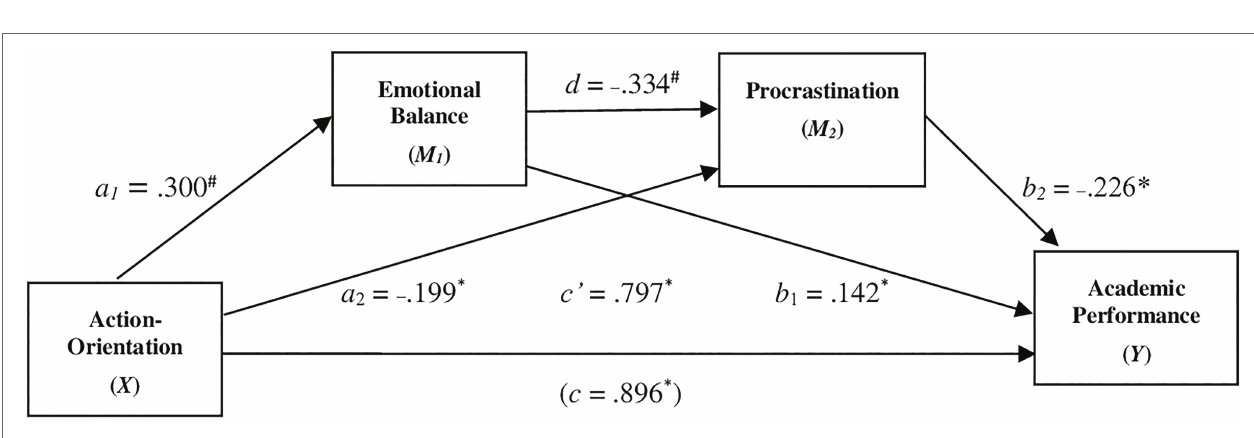
FIGURE 2 | The serial mediating effect of Emotional Balance and Procrastination in the relationship between Action- Oriantation and Academic Performance . * p < 0.05, ** p < 0.01, # p < 0.001; all presented effects are unstandardized; a n is effect of Action- Oriantation on mediators; b n is effect of mediators on Academic Performance: c ʹ is direct efffect of Action- Oriantation on Academic Performance; c is total effect of Action- Oriantation on Academic Performance; d is effect of emorional balance on